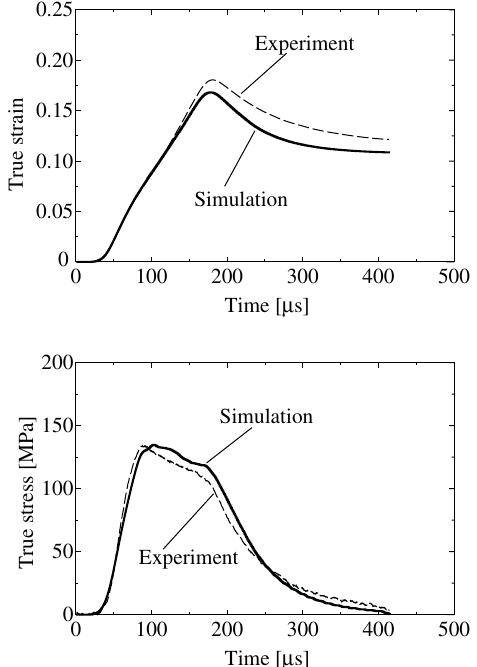
Fig. 9. Stress history and strain history at average strain rate of 1150 [1 / s].